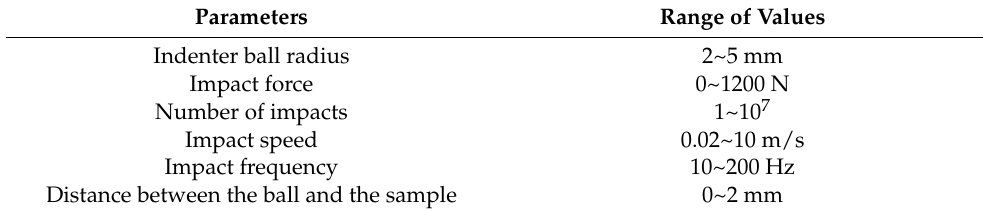
Figure 2. Sketch of the impact tester. Table 3. Typical impact testing